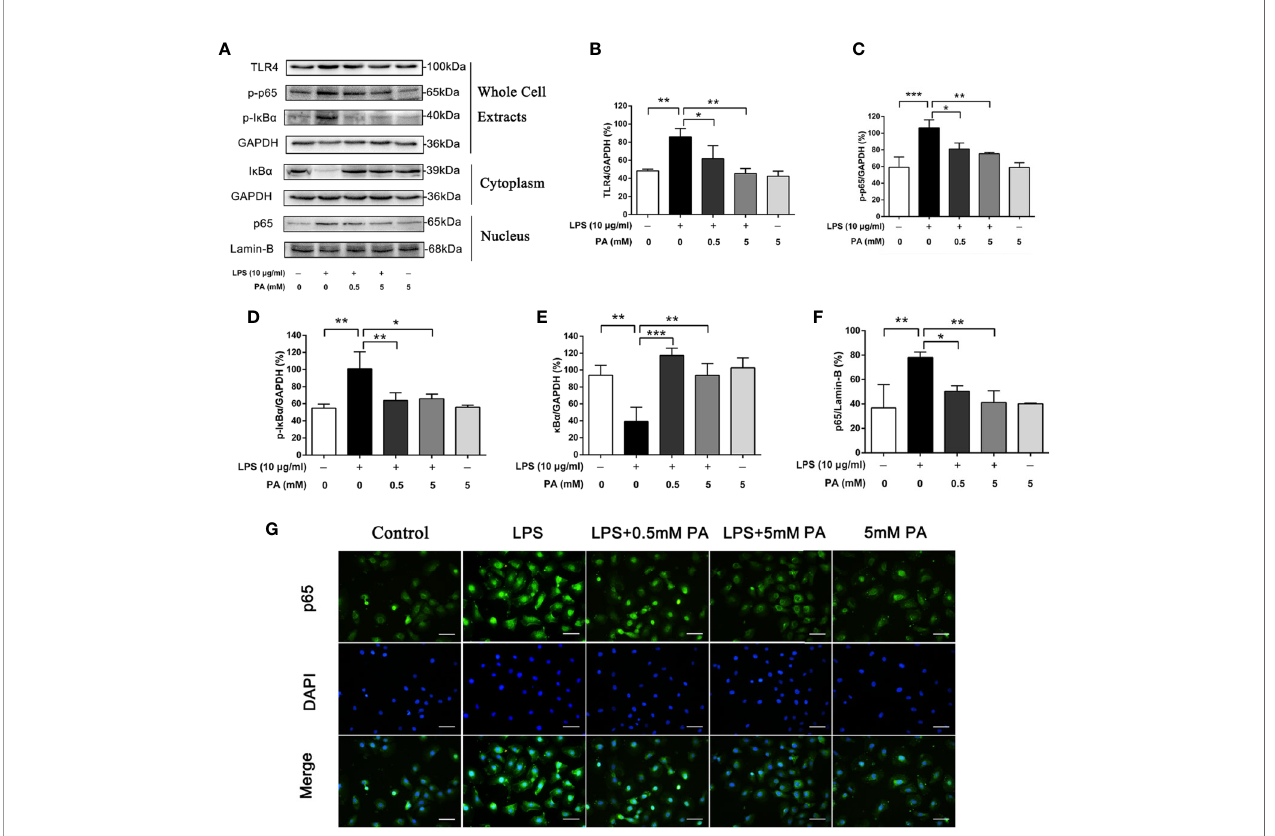
FIGURE 5 | The Effects of PA on the activation of TLR4/NF- k B pathway in LPS-induced IEC-6 cells. (A) The protein expressions of TLR4, p-I k B a and p-p65 in whole cell extracts, I k B a in the cytoplasm, and p65 in the nucleus in IEC-6 cells treated as above were visualized by western blot and were quanti fi ed in (B – F) . Relative expression of p-I k B a in whole cell extracts, p-p65 in whole cell extracts, and I k B a in the cytoplasm was expressed as a percentage of the level of GAPDH. Meanwhile, relative expression of p65 in the nucleus was expressed as a percentage of the level of Lamin-B. (G) The nuclear translocation of p65 was detected by immuno fl uorescence combined with DAPI staining for nuclei (scale bar: 30 m m). The data represent the averages ± S.D. Signi fi cant differences between the treatment and control groups are indicated as *P < 0.05, **P < 0.01, ***P < 0.001. Signi fi cance was determined by one-way